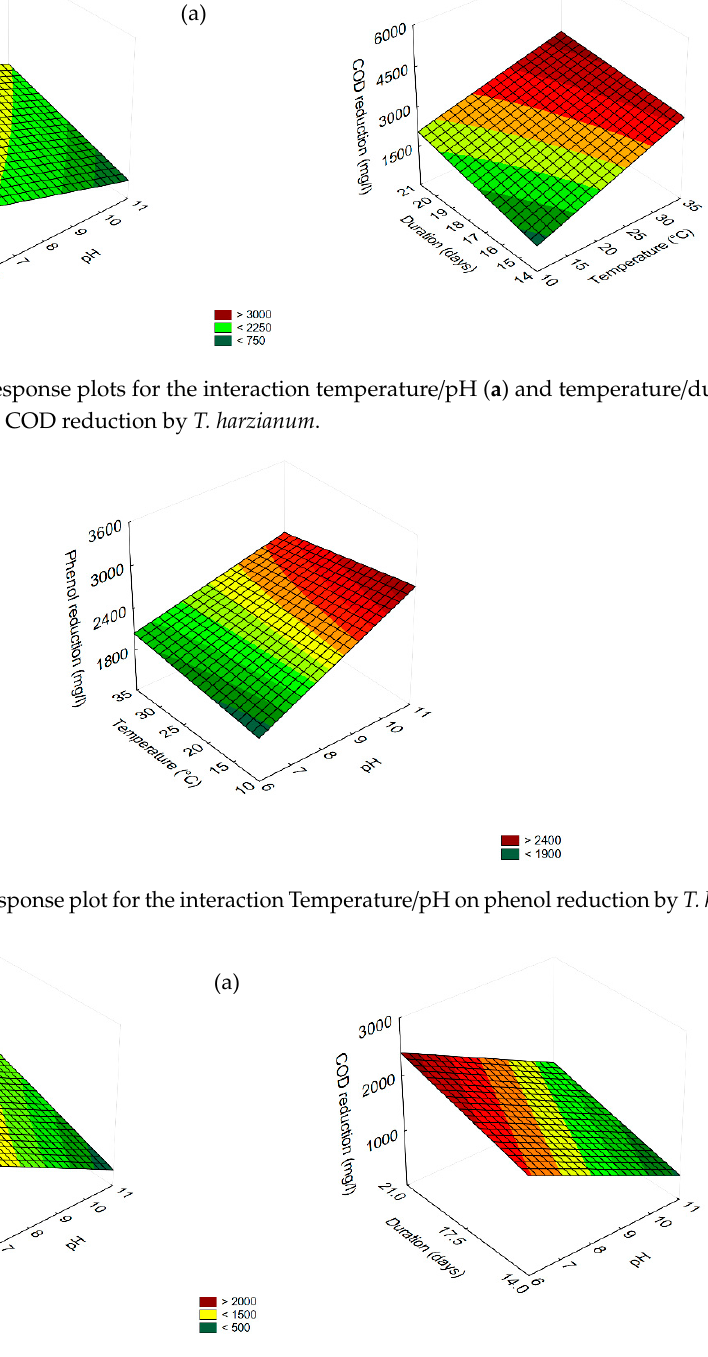
Figure 6. Surface response plots for the interactions temperature / pH ( a ) and duration / pH ( b ) on COD reduction in diluted TOPW by T. harzianum .